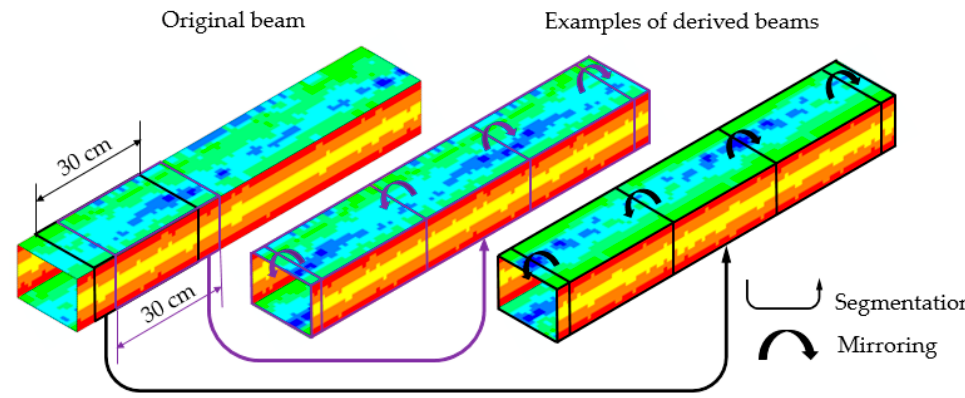
Figure 15. Shell element thickness for beams created by original beam segmentation and then by mirroring the segments. The color (from blue to red) indicates element thickness.